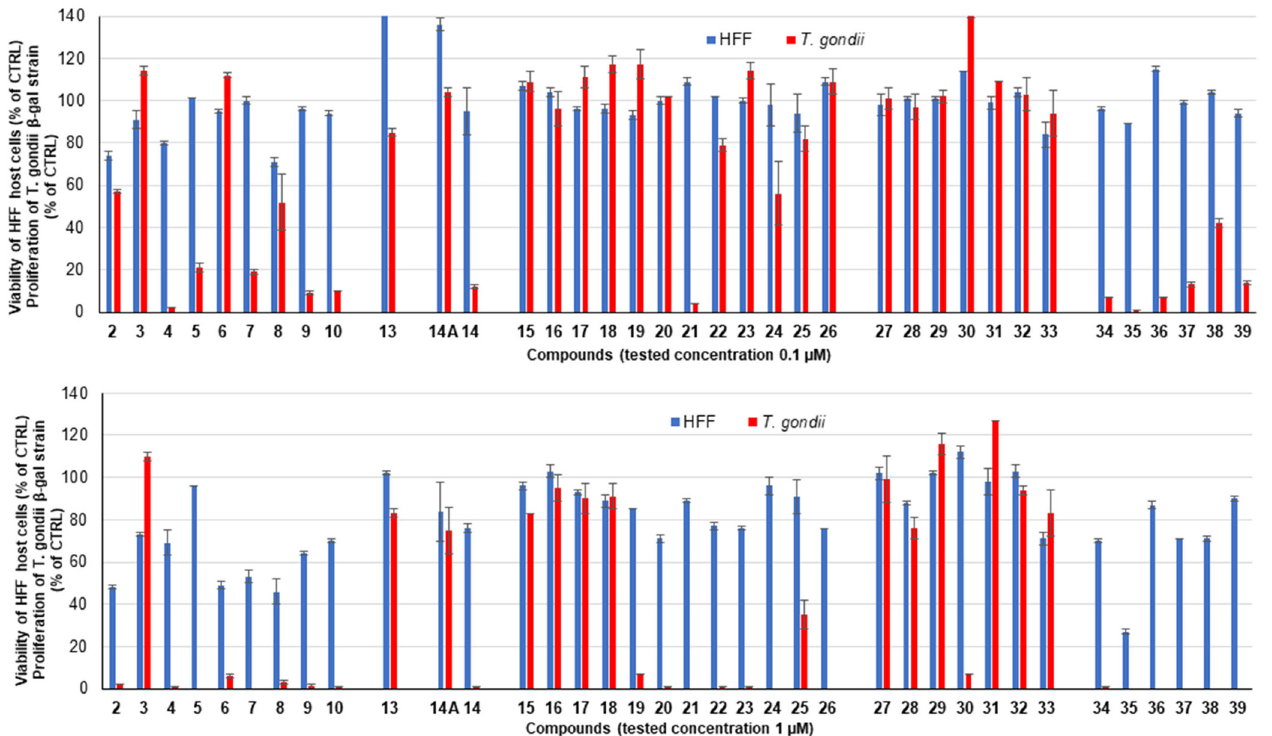
Figure 2. Clustered column chart showing the in vitro activities at 0.1 (top) and 1 μ M (bottom) of the tested compounds on HFF viability and T. gondii β -gal proliferation. Non-infected HFF monolayers treated only with 0.1% DMSO exhibited 100% viability and 100% proliferation was attributed to T. gondii β -gal tachyzoites treated only with 0.1% DMSO. For each assay, standard deviations were calculated from triplicates and are displayed on the graph. Data for compounds 2 – 4 and 8 were previously reported [79,82,97].